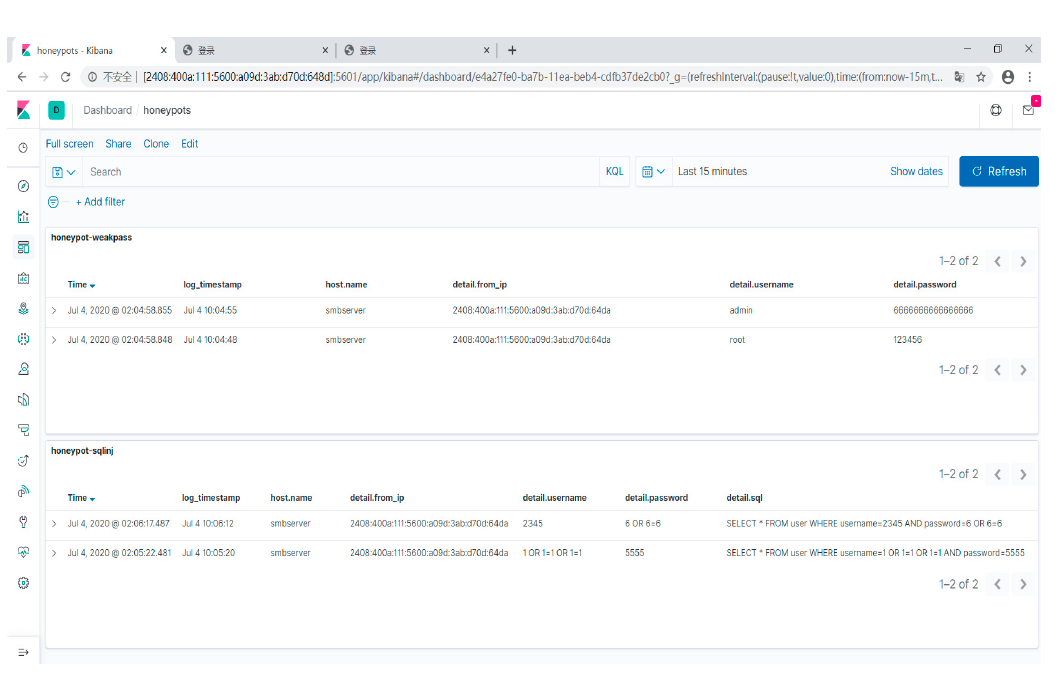
Figure 5. A SQL injection application.